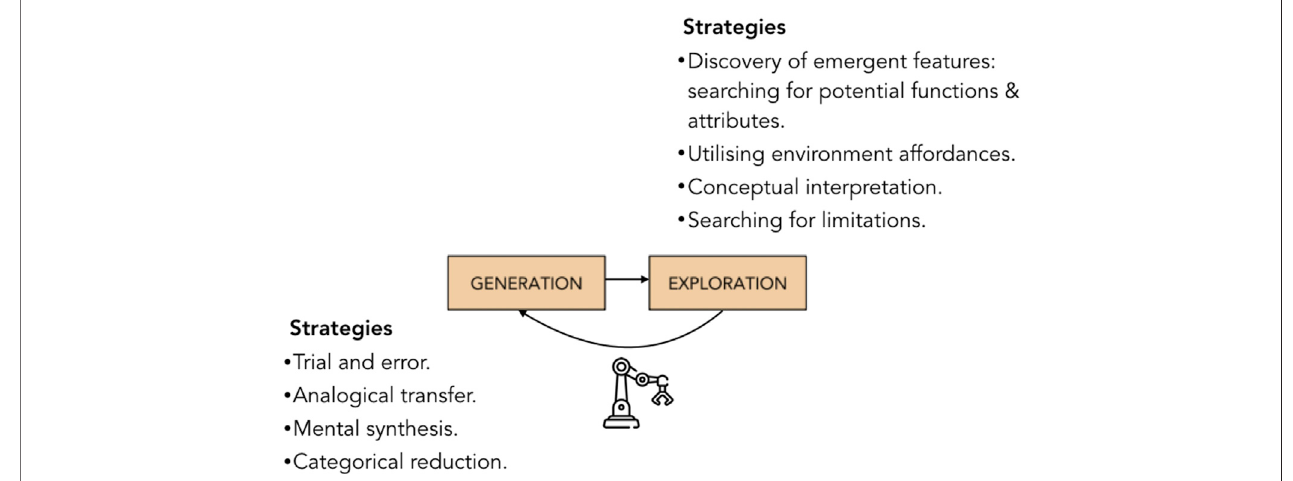
FIGURE 3 | Solution generation and